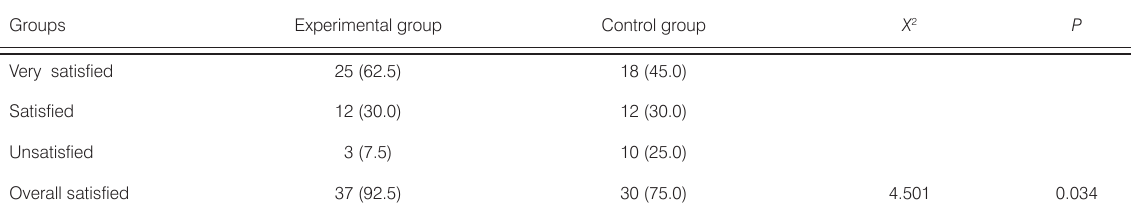
Table 2. Between group comparison of clinical nursing satisfaction, n (%) ( n = 40).